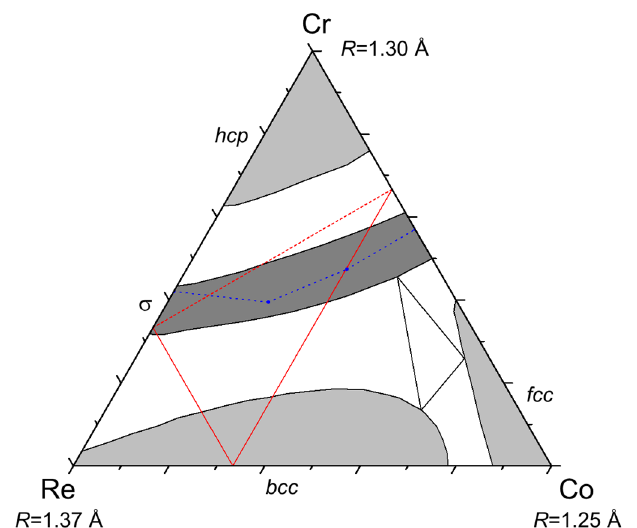
Figure 14. Isothermal section at 1150 °C of the Re–Cr–Co system (redrawn from [27], Copyright 1986, Elsevier Science). The red triangle shows the three ordered stable or metastable compositions of the σ phase, Re 2 Cr, Re 2 Co, and Cr 2 Co, as in Figure 2 (solid lines: normal substitution, dashed line: site reversal). The site occupancies of Figure 15 are calculated along the blue line joining experimental data points.